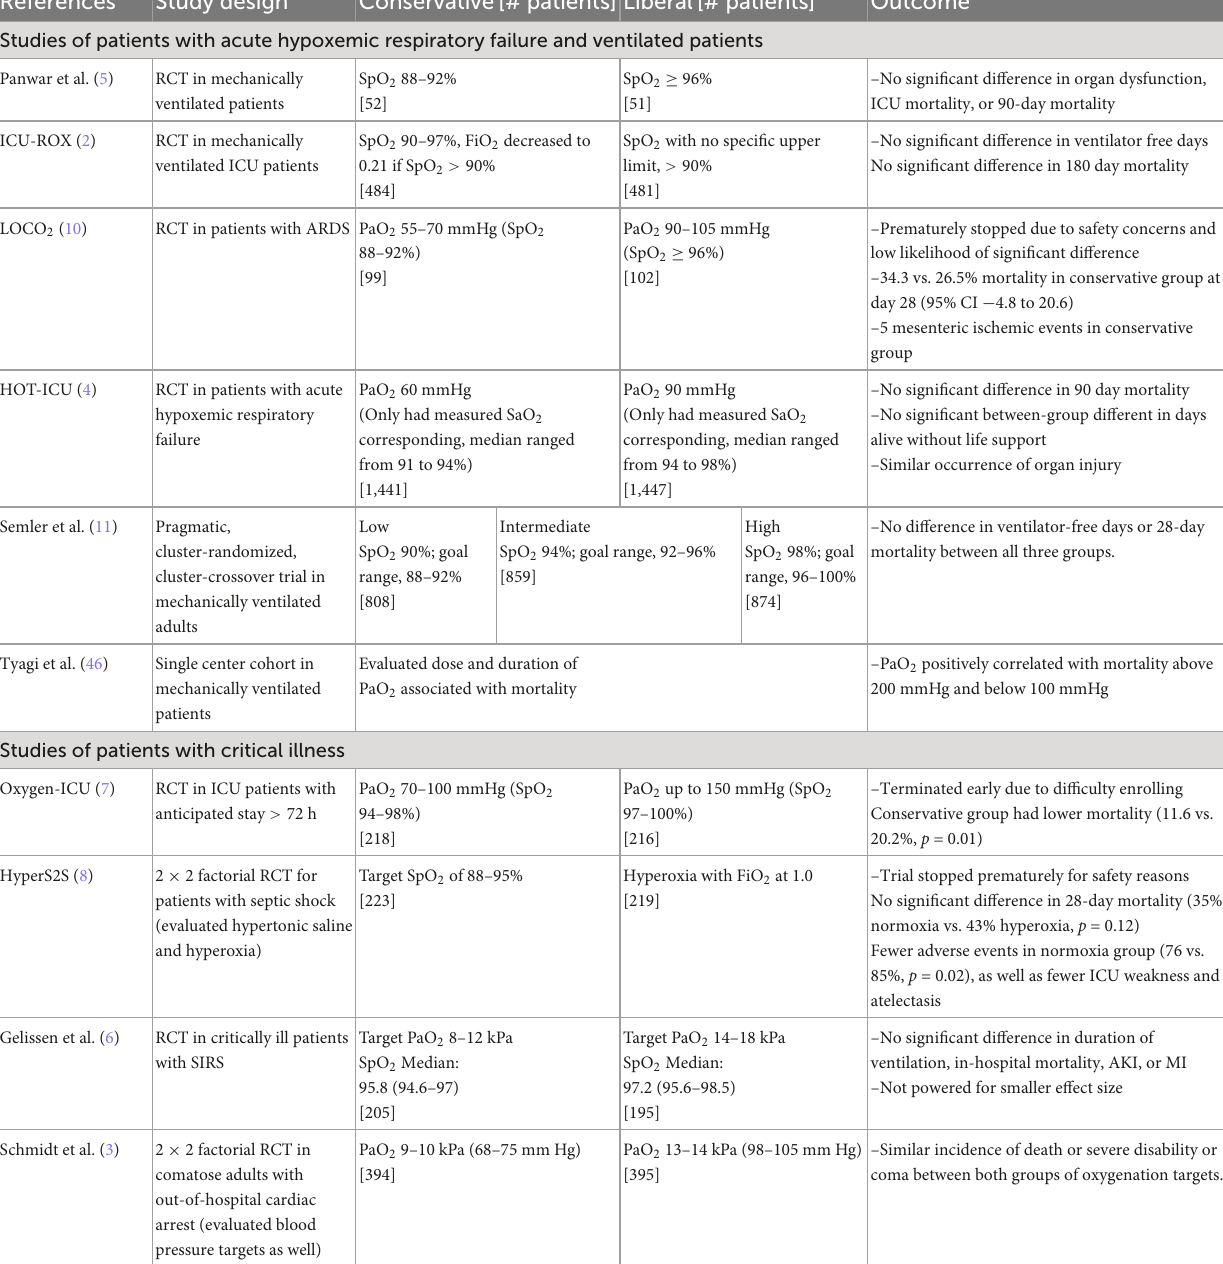
TABLE 3 Studies of conservative versus liberal oxygen saturation